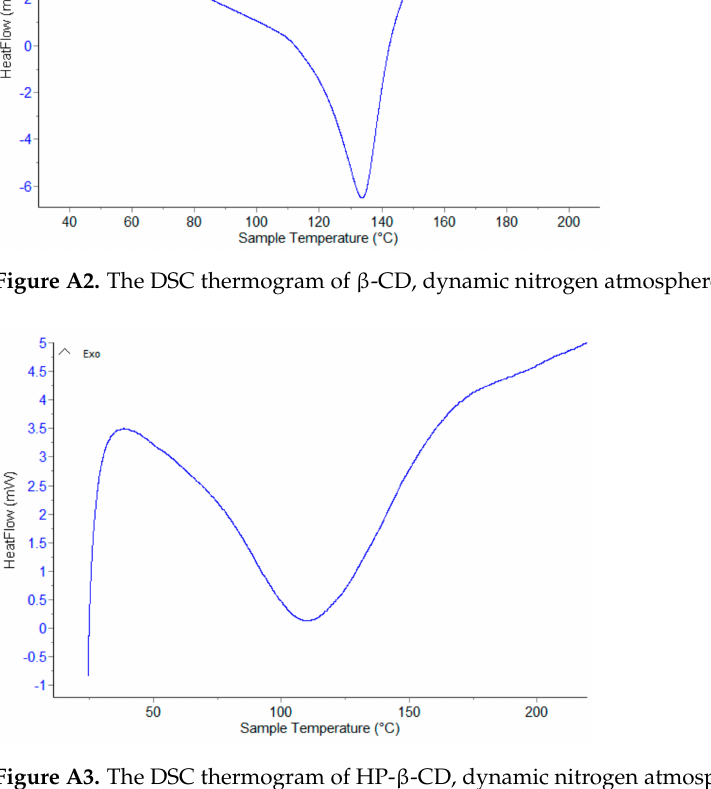
Figure A3. The DSC thermogram of HP- β -CD, dynamic nitrogen atmosphere, β = 10 K min − 1 .